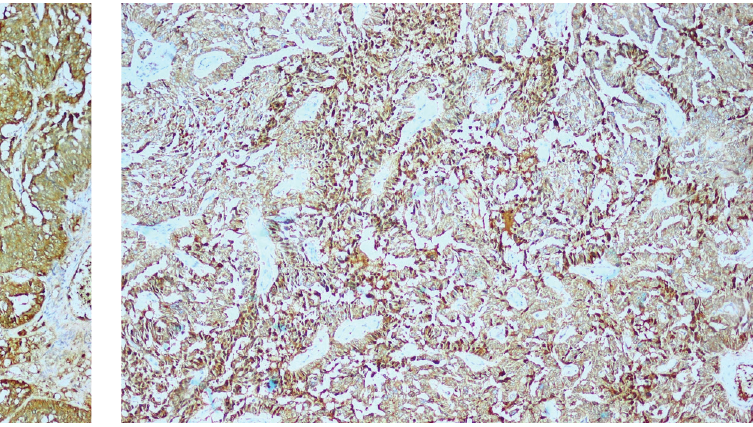
Figure 3 C - Calcitonin stain in the medullary carcinoma. Figure 3 D - Chromogranin stain in the medullary